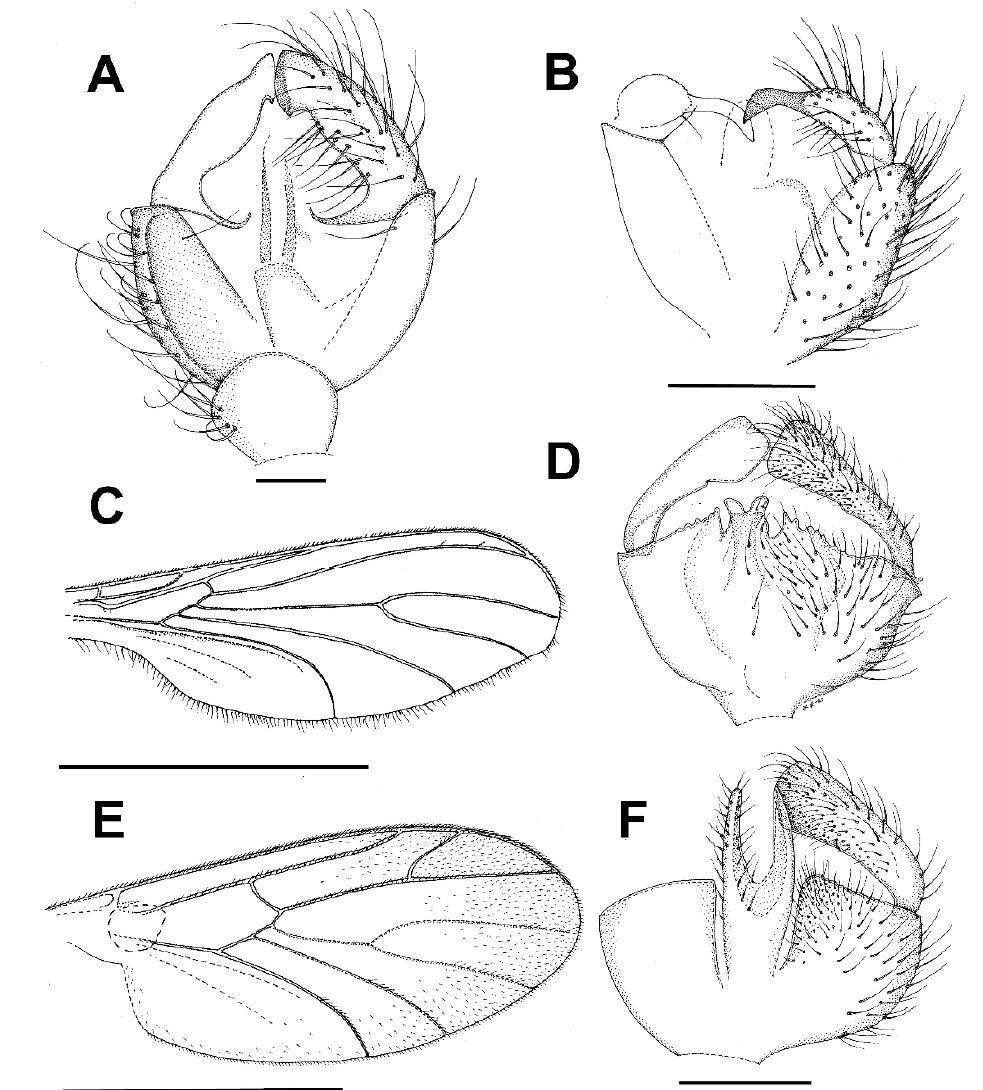
Figure 10. Male terminalia and wings of new fossil taxa. ( A , E ). Burmasymmerus korneliae gen. et sp. nov. (holotype, ( A ) male terminalia and ( E ) wing); ( B , C ). Burmatricha mesosoica gen. et sp. nov. (holotype, ( B ) male terminalia and ( C ) wing); ( D , F ). Burmasymmerus wieslawi gen. et sp. nov. (holotype, male terminalia, ( D ) ventral view, ( F ) dorsal view). Scale bars: 0.1 mm (terminalia), 1 mm (wings).